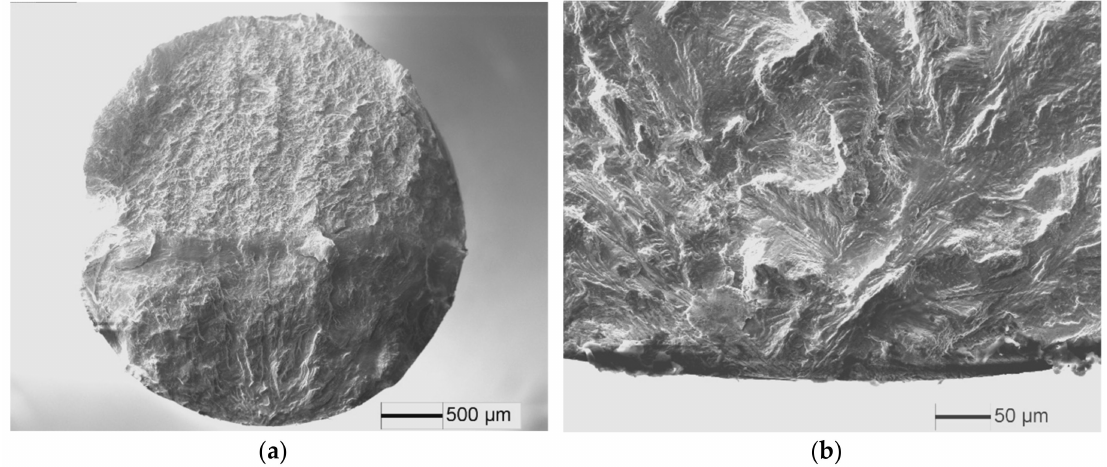
Figure 6. Fatigue fracture surface of TC21 titanium alloy at σ = 550 MPa and N = 2.37 × 10 5 cycles: ( a ) fatigue crack initiation site, and ( b ) high magnification morphology of crack initiation